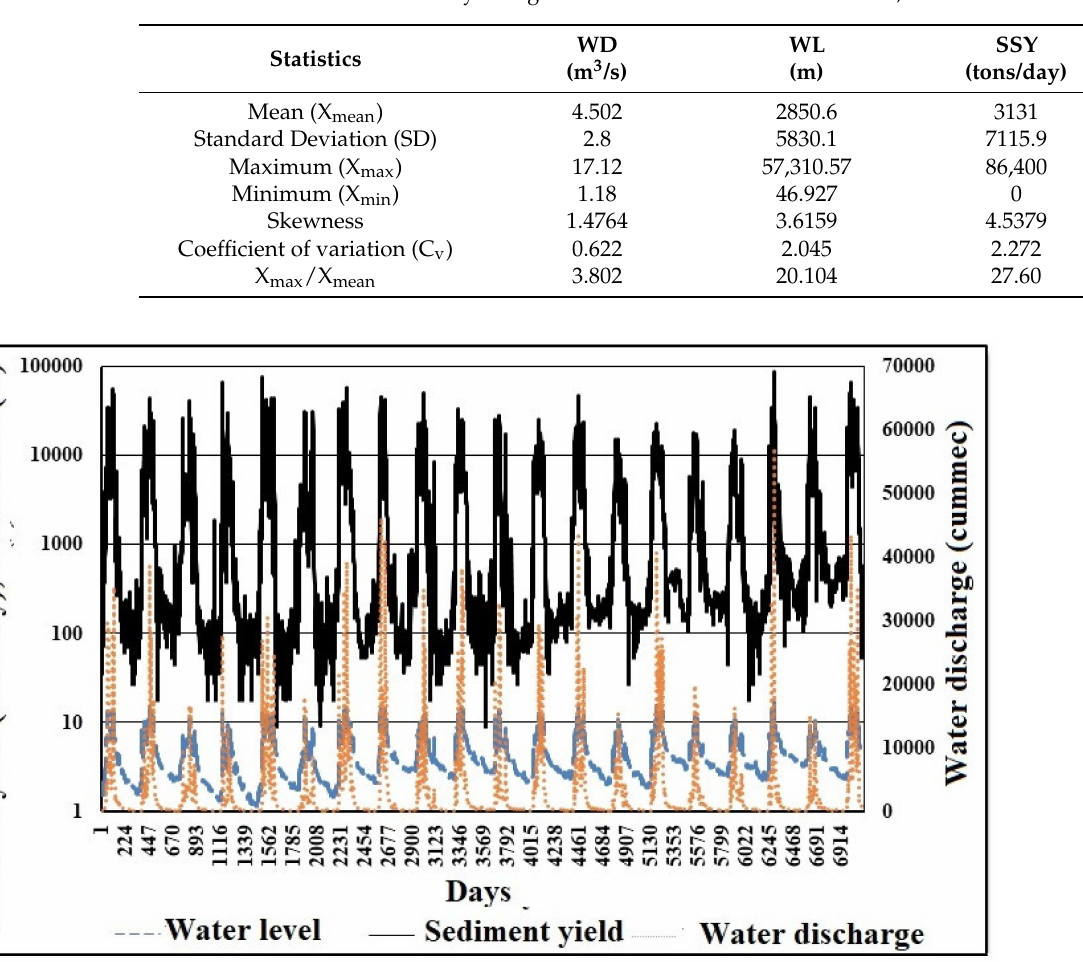
Table 1. Statistics constraints of hydrological and climatical data at Polavaram, Godavari River Basin.